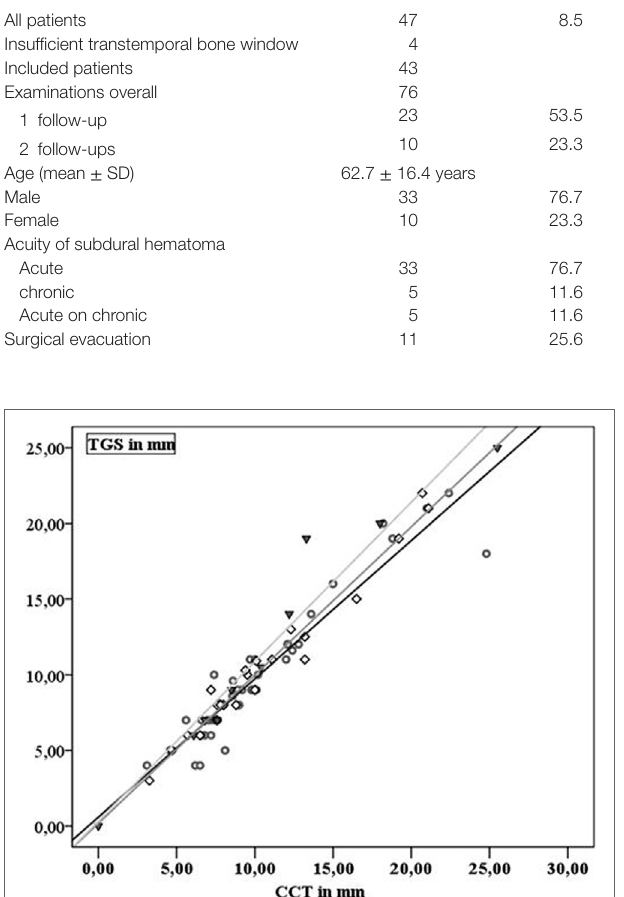
FigUre 2 | Gray dots and black line: first examination; black squares and dark gray line: second examination; black triangles and gray line: third examination.